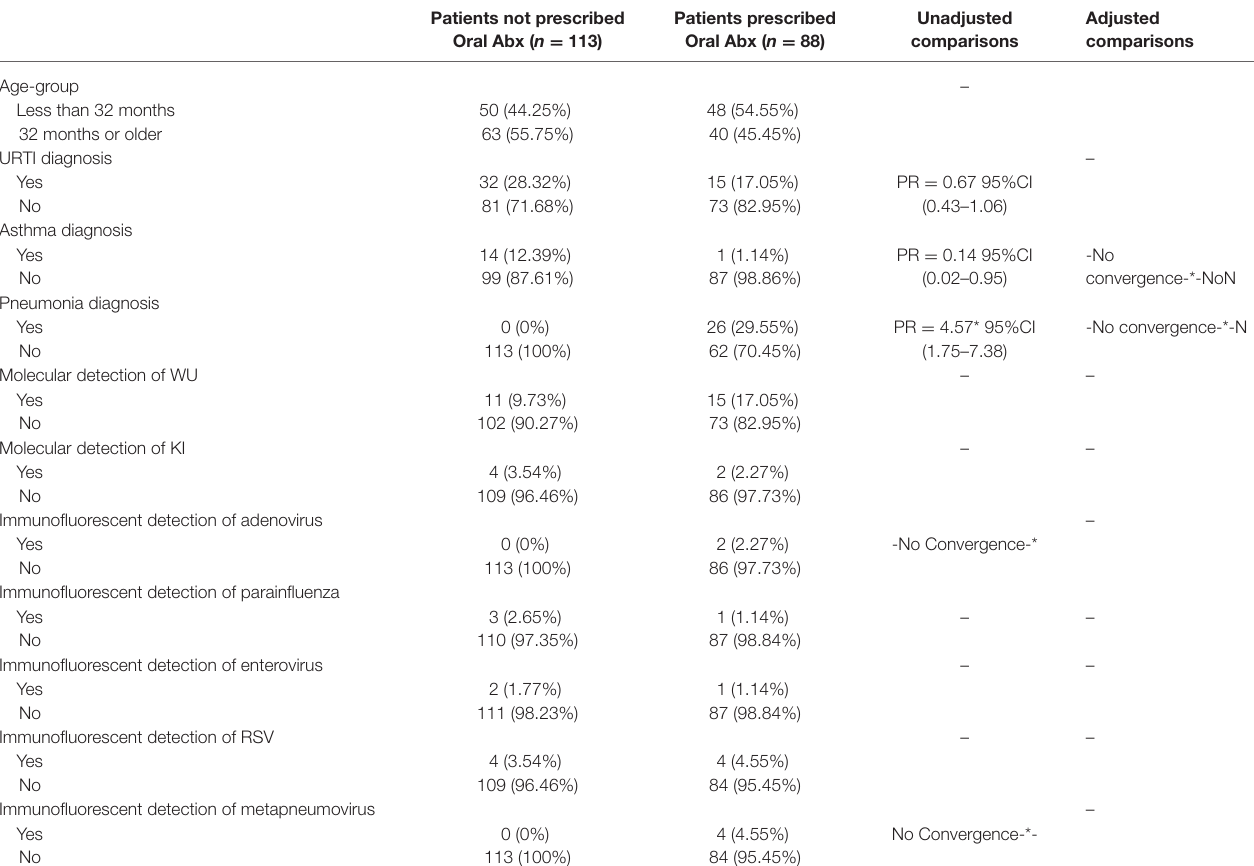
TABLE 5 | Characteristics of 201 pediatric study subjects and an examination of their risk factors for the use of oral antibiotics (abx), Singapore December 2016 to April 2017.